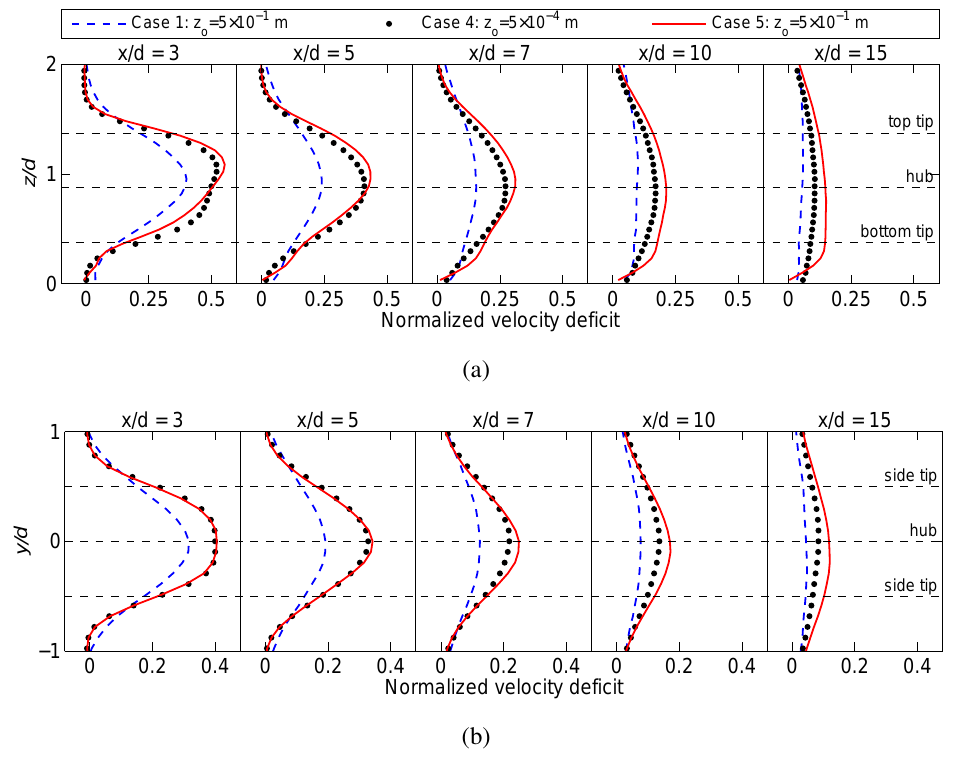
Figure 12. Comparison of vertical ( a ) and lateral ( b ) profiles of the normalized velocity deficit ∆ u/u through the centerline of the wakes. hub